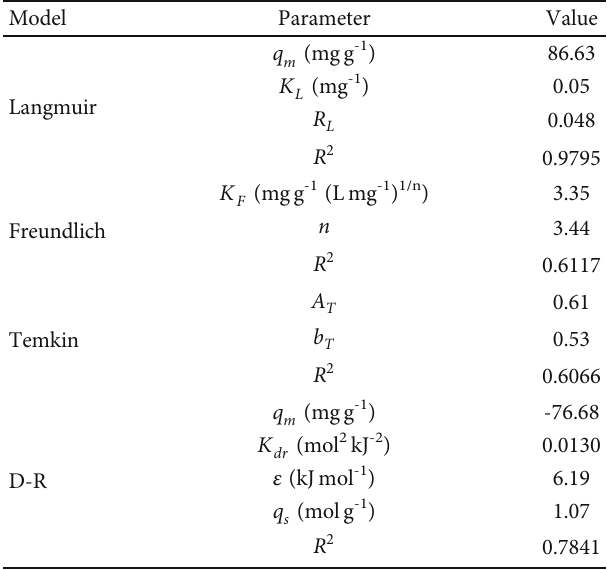
Table 3: Adsorption isotherm parameters for the adsorption of MB onto BC500.